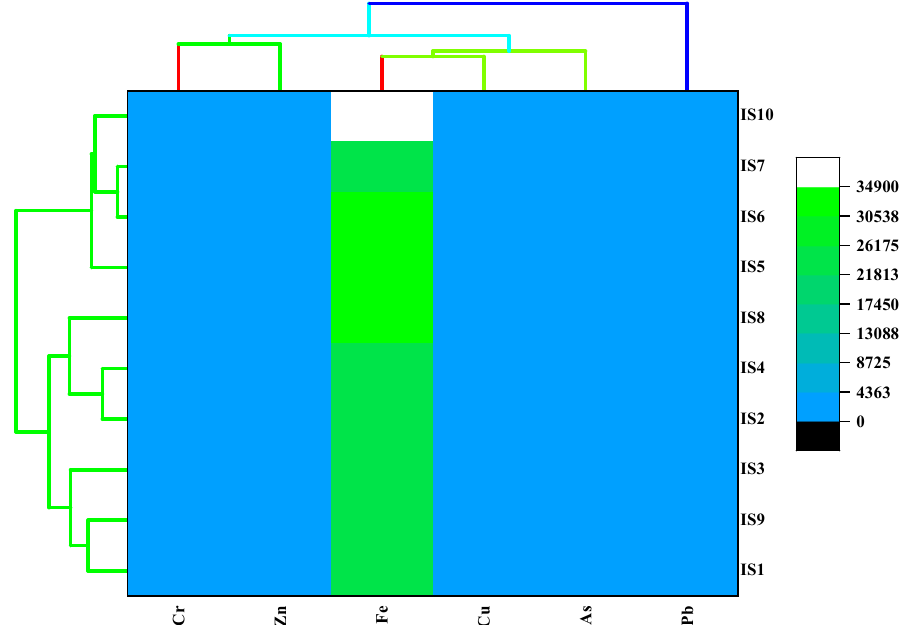
Figure 3. Hierarchical cluster diagram of sites of industrially affected soil samples (the distance reveals the degree of association between different sites based on the dissimilarity of heavy metals concentrations in soil samples).